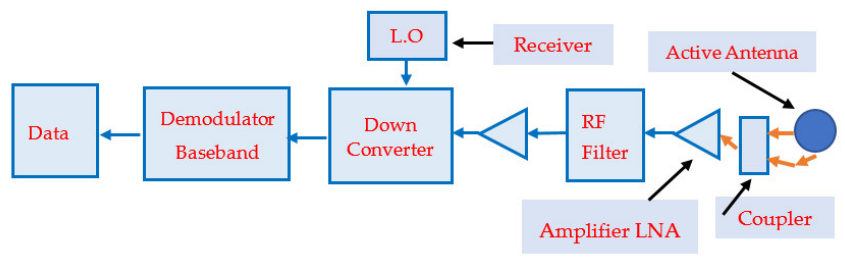
Table 6. Comparison of simulated and measured results of circular microstrip patches [15].